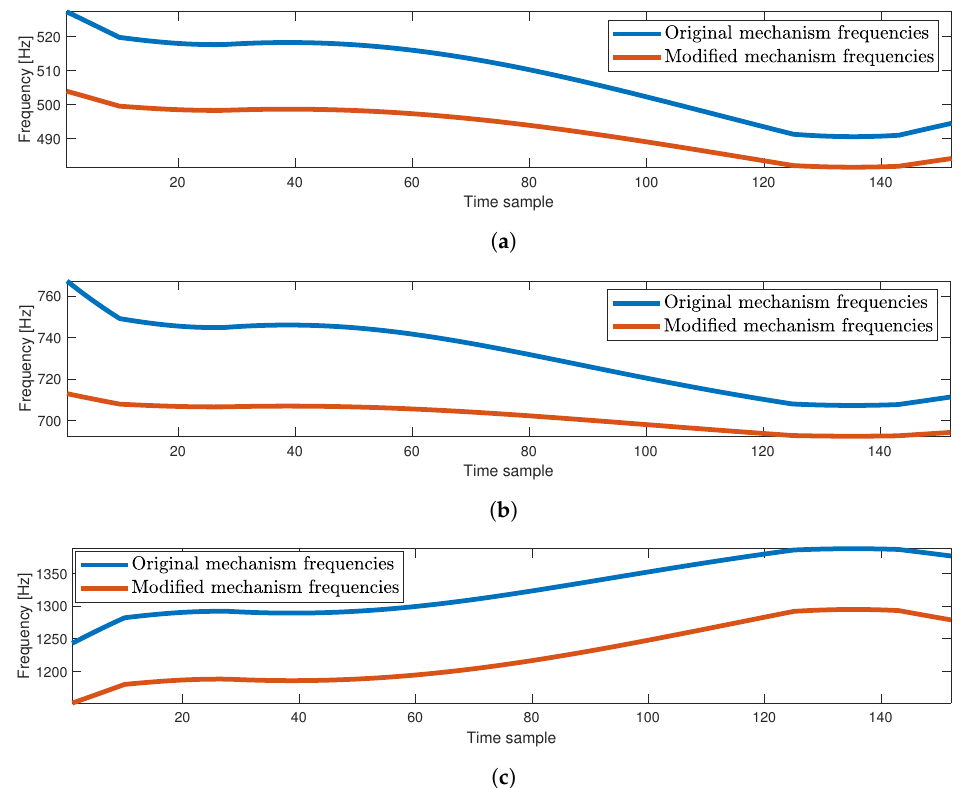
Figure 5. Comparison of the original and modified system eigenfrequencies in the ( a ) second mode; ( b ) third mode; ( c ) fourth